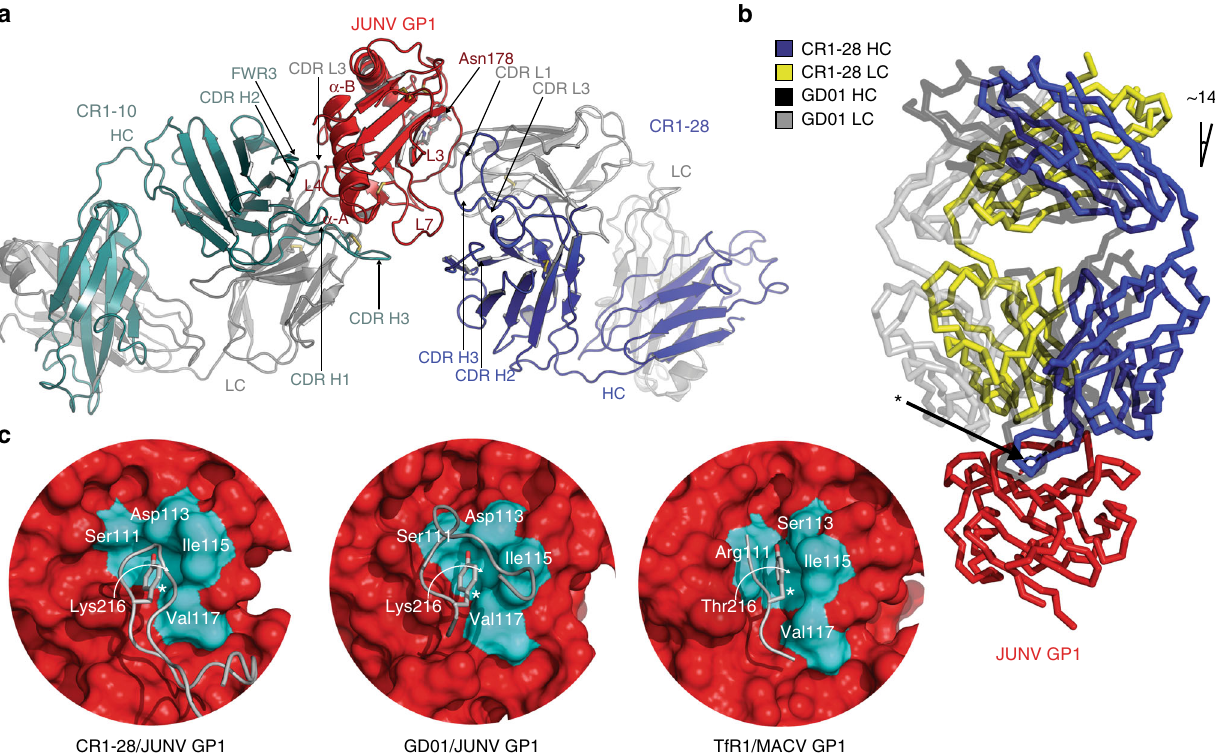
Fig. 3 Structure of a JUNV GP1 ternary Fab complex. a Ribbon diagram of JUNV GP1 (red) bound to CR1-10 (heavy chain in cyan, light chain in gray) and CR1-28 (heavy chain in purple, light chain in gray) Fabs. The antibody CDRs and GP1 segments involved in interactions are labeled. L: loop. LC: light chain. HC: heavy chain. A site of N-linked glycosylation at Asn178 (for which we observed interpretable density) is shown. Disul fi des are shown as yellow sticks. b Overlay of the JUNV GP1/GD01 Fab structure (PDB: 5EN2) 14 with the JUNV GP1/CR1-28 Fab subcomplex. The difference in the angle of Fab approach (from the perspective of the variable domain) is indicated and is similar for all copies in the ASU. The side chain for a tyrosine that is conserved in the CDR H3 of both antibodies is shown as sticks and indicated with an arrow. c Surface representation of GP1 (red) with interacting segments of CR1-28 CDR H3 (leftmost panel), GD01 CDR H3 (PDB: 5EN2, 14 middle panel), or the TfR1 β II-2 strand (PDB: 3KAS, 13 rightmost panel) shown in cartoon representation. Residues that line the Tyr211 TfR1 pocket are shown in cyan and labeled — the residue that lines the back of the GP1 pocket is indicated with a curved arrow. The tyrosine side chain that occupies the GP1 pocket in each instance is shown as sticks and is indicated with an